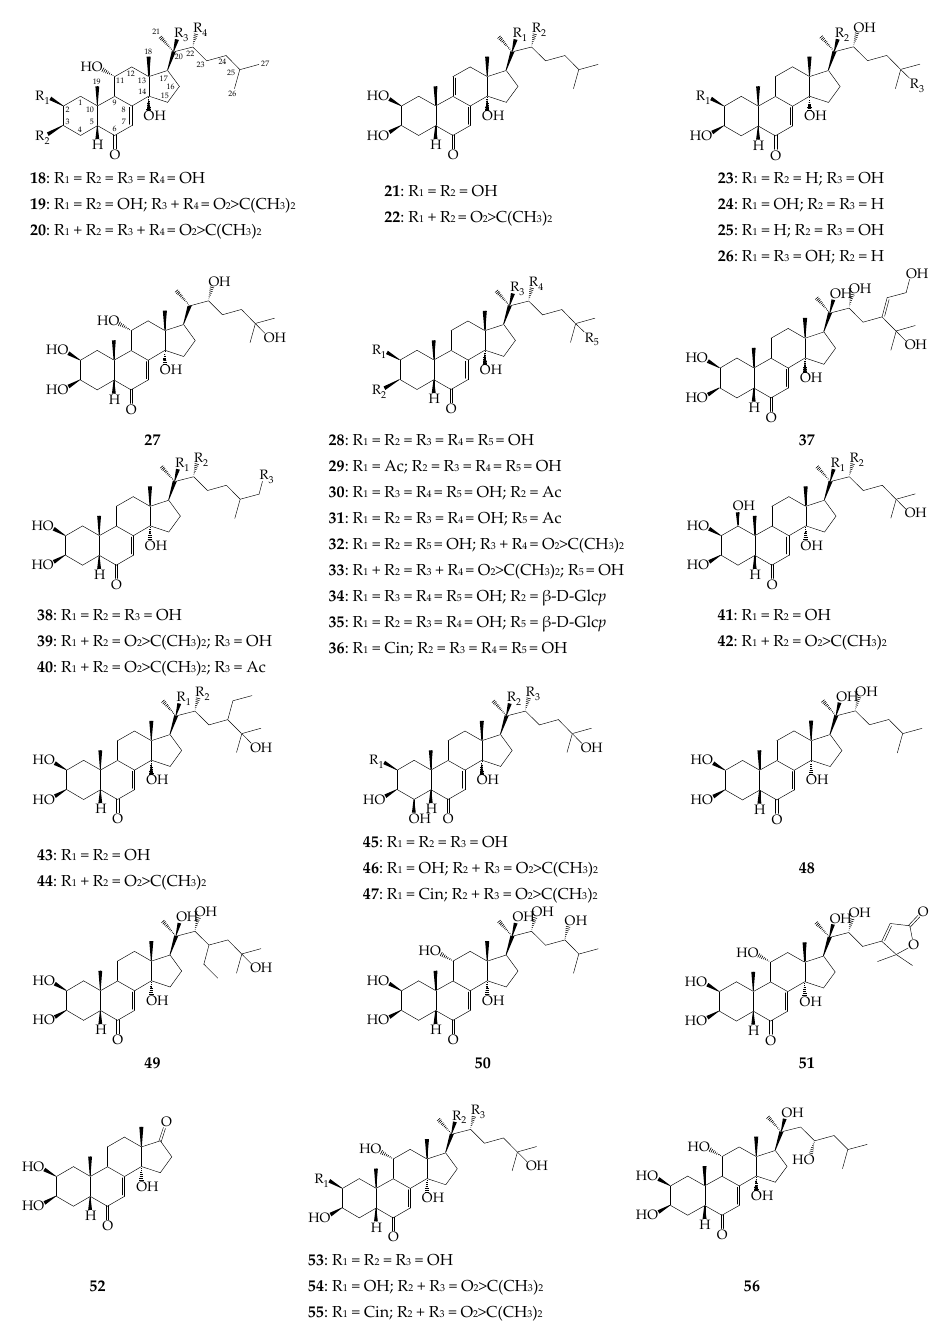
Figure 3 . Ecdysteroids 18 – 56 . Ac–acetyl; Cin–cinnamoyl; β -D-Glc p – β -D-glucopyranose. Figure 3. Ecdysteroids 18 – 56 . Ac–acetyl; Cin–cinnamoyl; β -D-Glc p – β Comparing the chemodiversity of the ecdysteroids in R. uniflorum with that of the more-studied species R. carthamoides (in which more than 50 compounds of this class have been identified so far [20]), it can be assumed that there are many more compounds in the composition of the steroid metabolome of R. uniflorum . Different organs of R. uniflorum are the sources of 25 non-ecdysteroid triterpenoids ( 57 – 81 ), including 23 compounds isolated from the roots and five components detected in the herb ( 57 , 59 – 61 , 79 ) (Figure 4). The only tetracyclic triterpene roburic acid ( 57 ), typical for Gentiana roots [51], was detected in the flowers of R. uniflorum [9]. The remaining com- pounds ( 58 – 81 ) were pentacyclic triterpenes. Ursans are the dominant structural type of R. uniflorum triterpenes (21 compounds), as opposed to oleanans, represented by fewer components (3 compounds). Triterpenoids of R. uniflorum can contain unsaturated bonds at С 9 – С 11 , С 12 – С 13 , С 18 – С 19 , С 19 – С 29 , hydroxyl groups at С 2 , С 3 , С 19 , and С 25 and carboxyl groups at С 23 and С 28 . Eleven compounds have been identified as mono- and di-glyco- sides, including fragments of β -D-glucose and/or α -L-arabinose at C 3 and/or C 28 . Two al- cohols, α - ( 59 ) and β -amyrins ( 79 ) [35], as well as two acids, 3-oxo-ursus-12-en-24-oic acid (as methyl ether, 60 ) [35] and ursolic acid ( 61 ) [30], have been detected in the R. uniflorum herb. Triterpenoids of R. uniflorum roots are notable for their large structural diversity of the primary ursan skeleton, as well as their ability to form glycosides identified only in this part of the plant. The basic triterpene aglycones are 3 β -hydroxy-urs-12,18(19)-dien- 28-oic acid as glycosides 62 – 64 [25,39], 3 β -hydroxy-urs-12,19(29)-dien-28-oic acid as gly- cosides 66 and 67 [25,39], pomolic acid (3 β ,19 α -dihydroxy-urs-12-en-28-oic acid, 68 ) [25, 41] and tormentic acid (2 α ,3 β ,19 α -trihydroxy-urs-12-en-28-oic acid, 73 ) [36]. Of note, the 3 β -hydroxy functional group is typical for R. uniflorum triterpenoids, except in three com- pounds with a 3 α -hydroxy functional group, including 76 [25, 41], 77 [41], and 76 [25], isolated from the roots of R. uniflorum growing in China. A few oleanan derivatives in- clude β -amyrin ( 79 ) [35], oleanolic acid ( 80 ) [40], and arjunic acid ( 81 ) [36]. Five stigmas- tane derivatives have been found in the R. uniflorum herb and roots, including β -sitosterol ( 82 ) and its glucosides daucosterol ( 83 ) [25, 35, 40, 41], stigmasterol ( 84 ) [35, 41], stigmas- tan-3,5-diene ( 85 ) [35], and stigmast-4-en-3-one ( 86 ) [35]. HO O